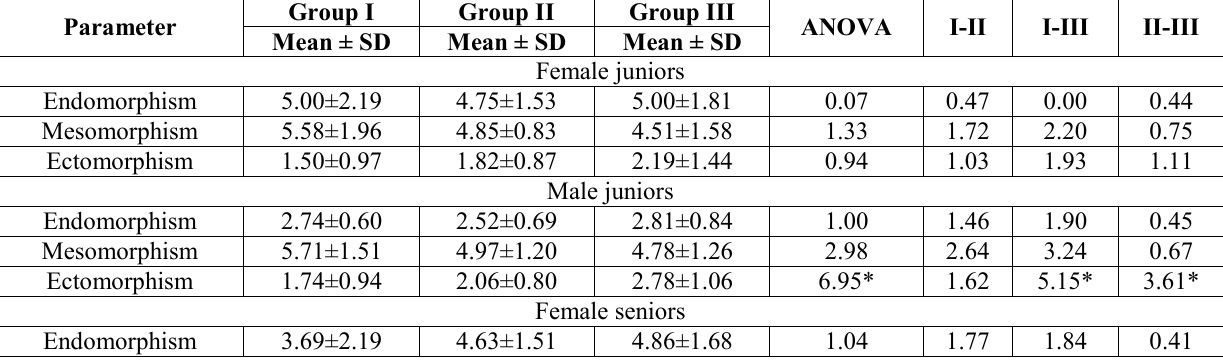
Types of body structure along with the statistical significance of differences in weightlifters depending on their sports